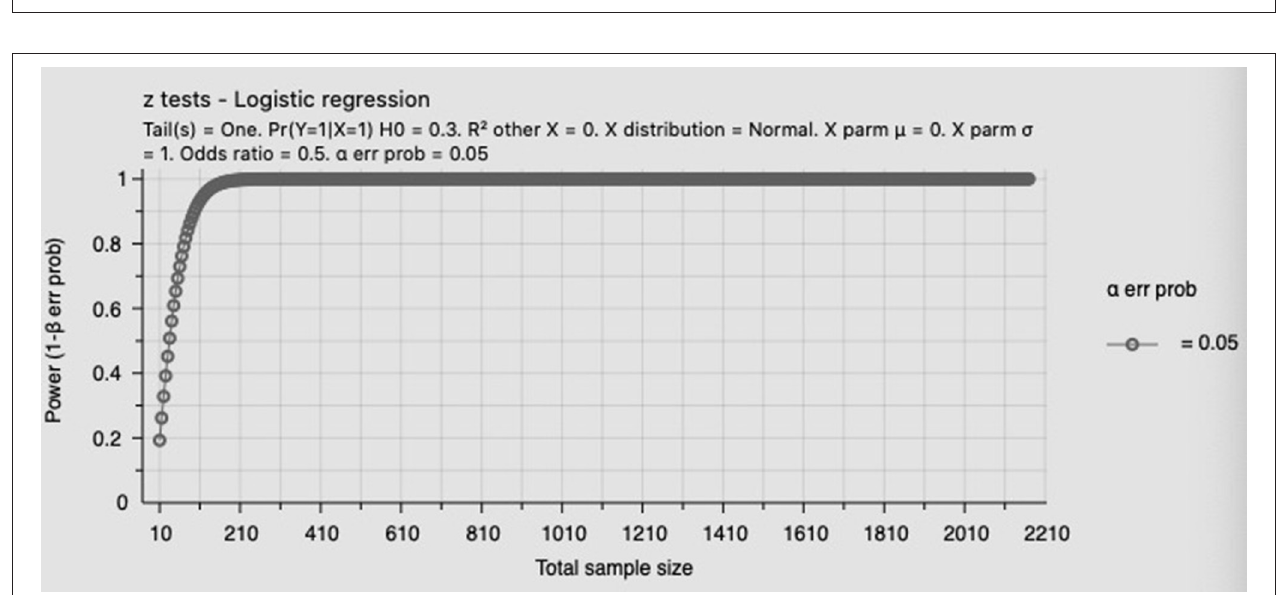
FIGURE 2 | Power analysis for total